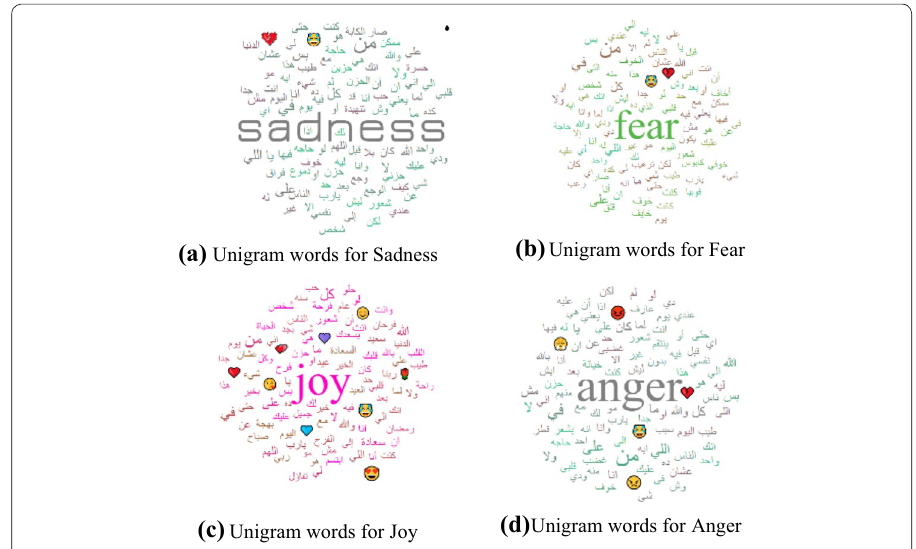
Fig. 1 Correlations between Arabic words and emotions: based on the frequency of the word n-grams for each